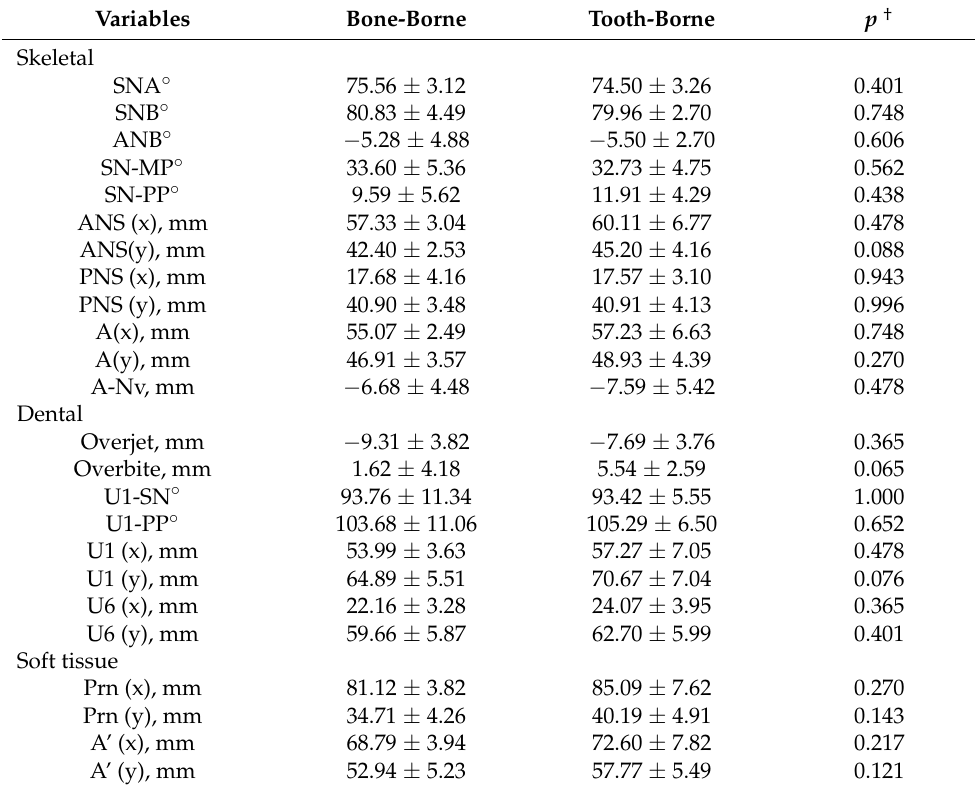
Table 3. The pre-distraction cephalometric measurements in the bone-borne RED group and the traditional tooth-borne RED group. Variables Bone-Borne